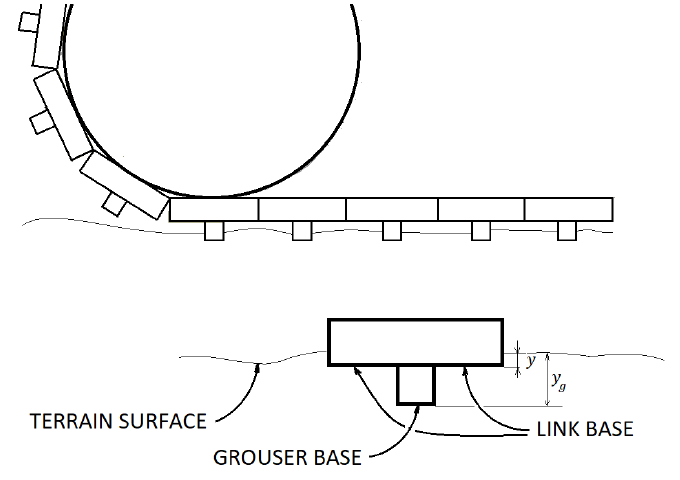
Figure 13. Virtual grouser